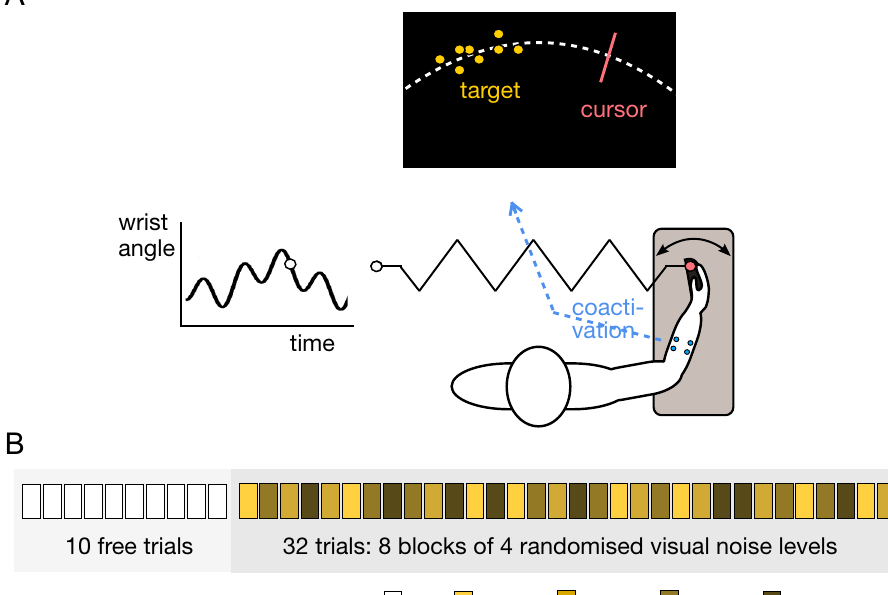
Figure 1. Schematic of the experimental task and protocol. ( A ) Subjects tracked a randomly moving target with their wrist flexion-extension movement while being connected to the target trajectory through a virtual spring. The spring’s stiffness increased with the coactivation of a flexor–extensor muscle pair, measured from their normalized myoelectrical activity. ( B ) The experimental protocol consisted of 10 training trials and 32 visual noise trials. The virtual spring was implemented in the visual noise